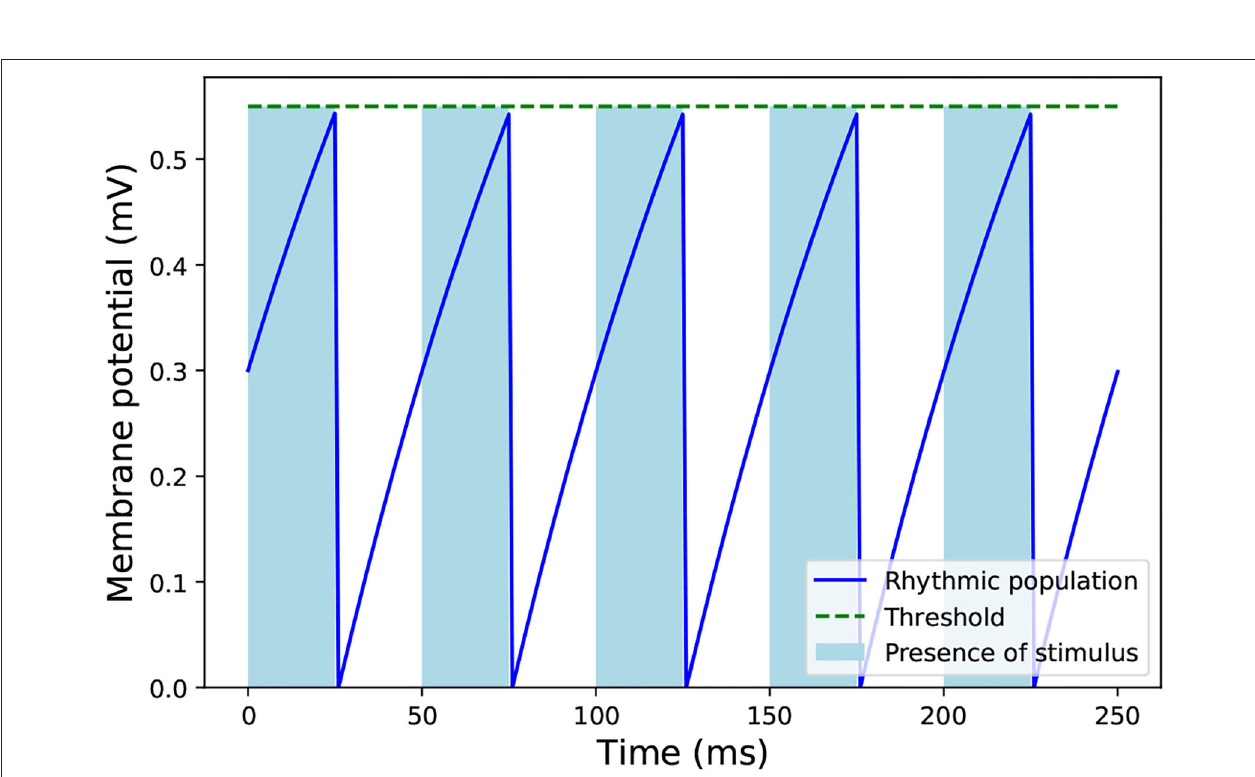
FIGURE 5 | Dynamics of the rhythmic inhibitory neuron connected to the liquid population in SpiNNaker. The light blue stripes indicate the presence of an input stimulus to the network. After the stimulus ends, the inhibitory neuron emits a spike which reduces the activity of the liquid population of the LSM, so it does not affect the next